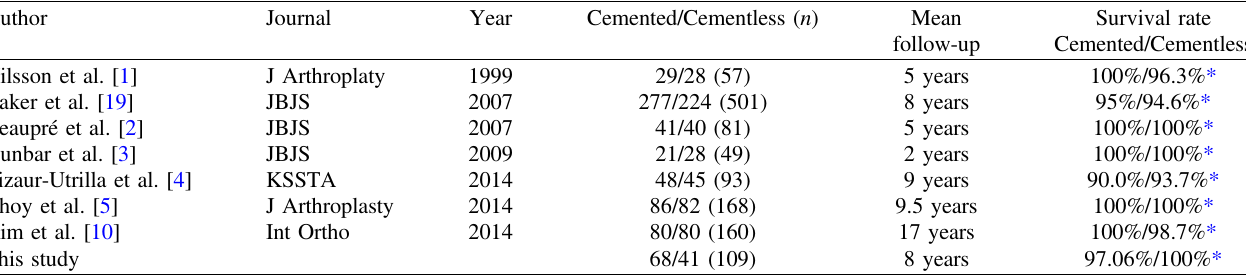
Table 4. Randomized controlled trials assessing the survival rates of cemented versus cementless tibial component, compared to our